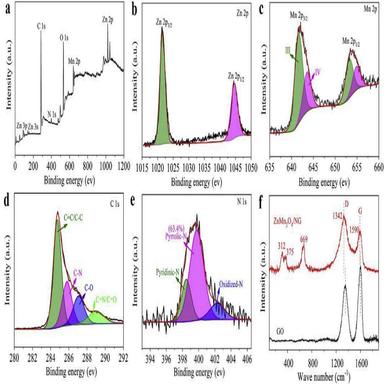
XPS (a) full, (b) Zn 2p, (c) Mn 2p, (d) C 1s, and (e) N 1s spectra of ZnMn2O4/NG. (f) Raman spectra of ZnMn2O4/NG and individual GO.